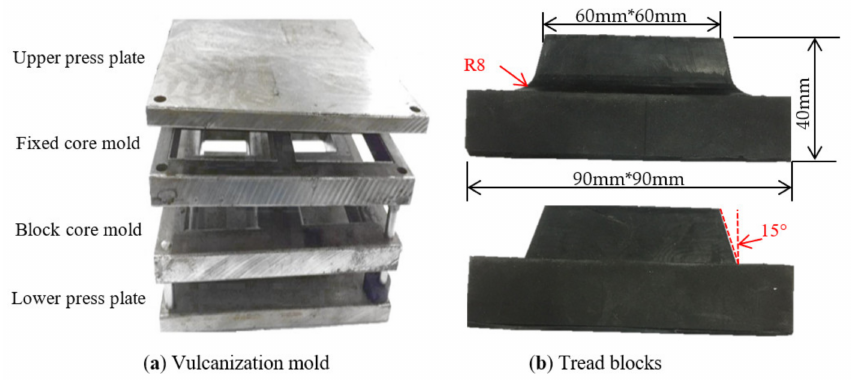
Figure 2. Vulcanizing mold and test samples.